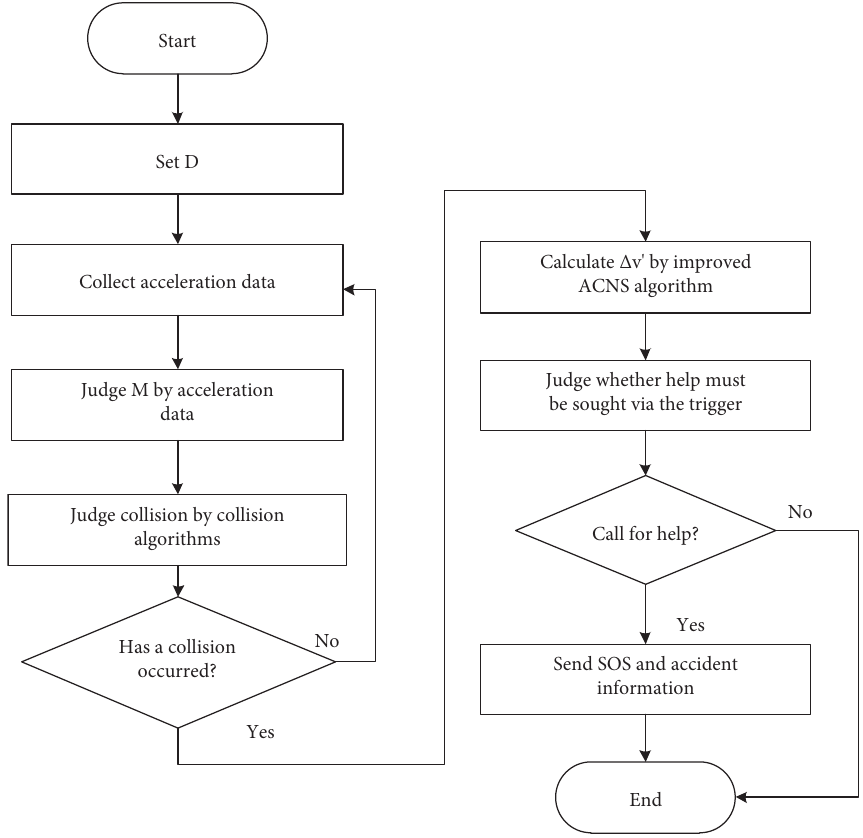
Figure 16: ACN algorithm with VVCF